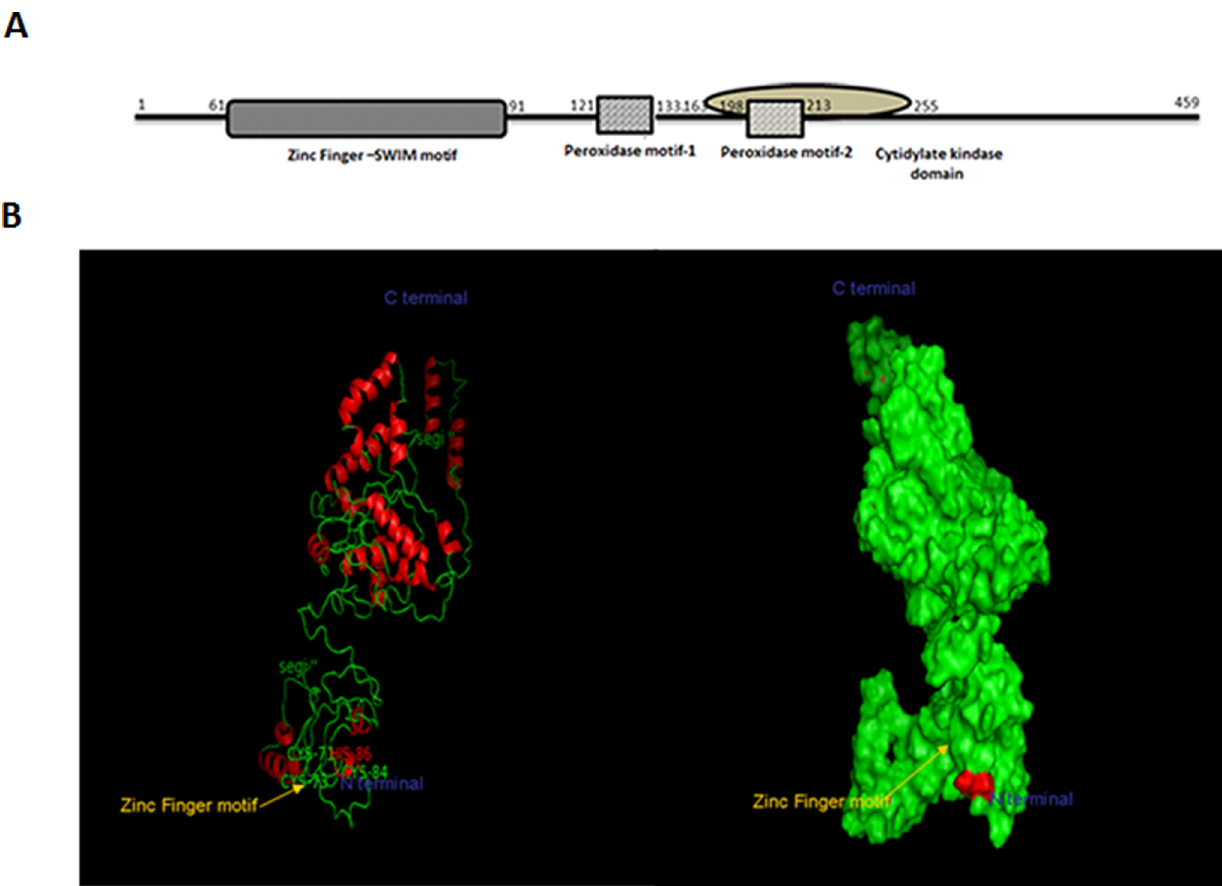
Figure 6. The domain architecture of PG1037. A: Domain architecture of PG1037 shows a ZINC finger – SWIM domain that can interact with DNA, proteins and also may also be involved in reducing oxidative lesions in the DNA. This is followed by two peroxidase motifs which scavenges the peroxide radicals. The cytidylate kinase domain flanking the second peroxidase motif, could be involved in the transferring of phosphate groups. B: The Zinc finger attachment site in